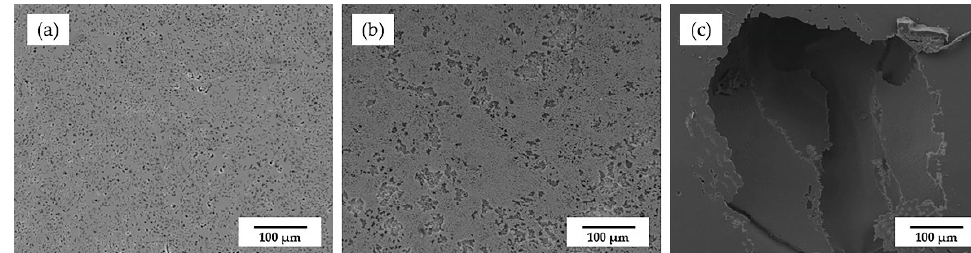
Figure 12. Surface morphology of the samples after a 2 h potentiodynamic polarization test: ( a ) 55NiTi + 5Ni coating; ( b ) 55NiTi coating; ( c ) substrate stainless steel 316L.